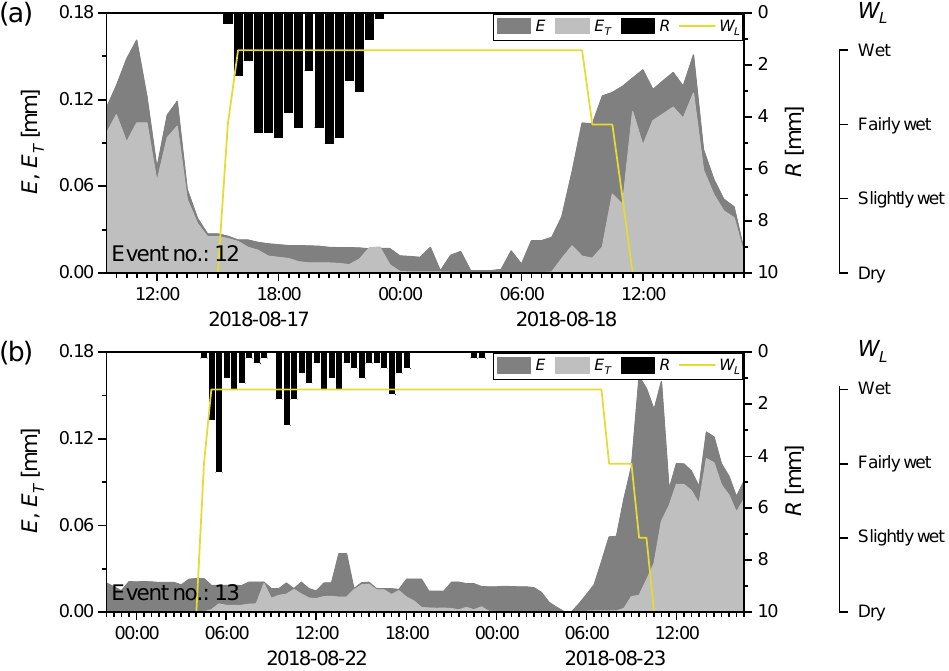
Figure 7. Effect of rain events ( R ) from ( a ) 15:30 until 23:00 of 17 August 2018 and from ( b ) 04:30 until 18:00 of 22 August 2018 on half-hourly canopy wetness level ( W L ), evapotranspiration ( E ), and transpiration ( E T